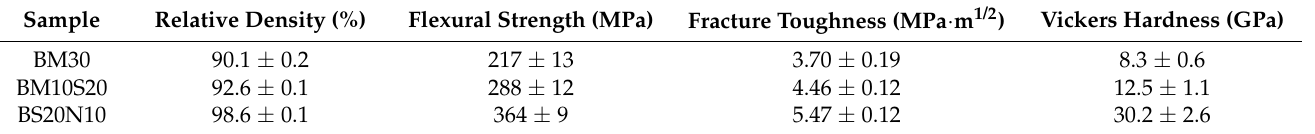
Figure 7. ( a – c ) SEM images of the polished surfaces and ( d ) plot of the average grain sizes in the samples. Table 2. Mechanical properties of the B 4 C/TiB 2 ceramic